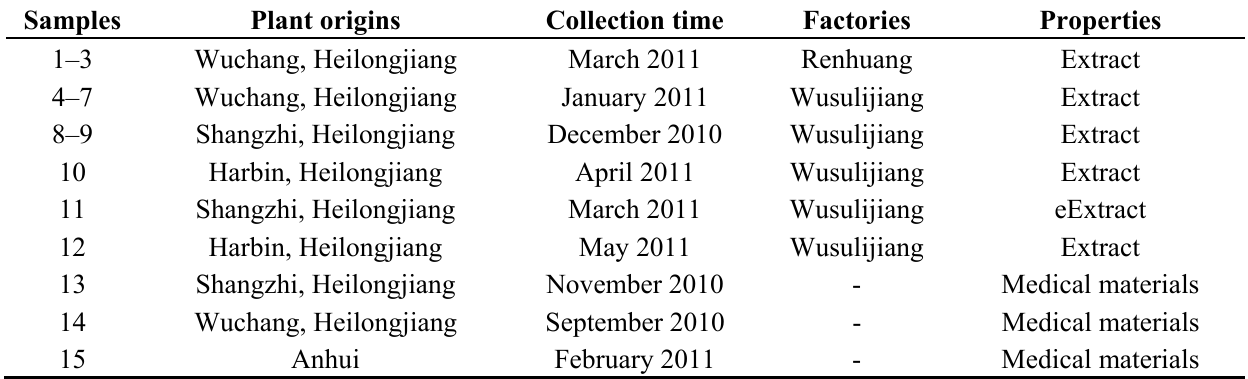
Table 4. Detailed information of A. senticosus